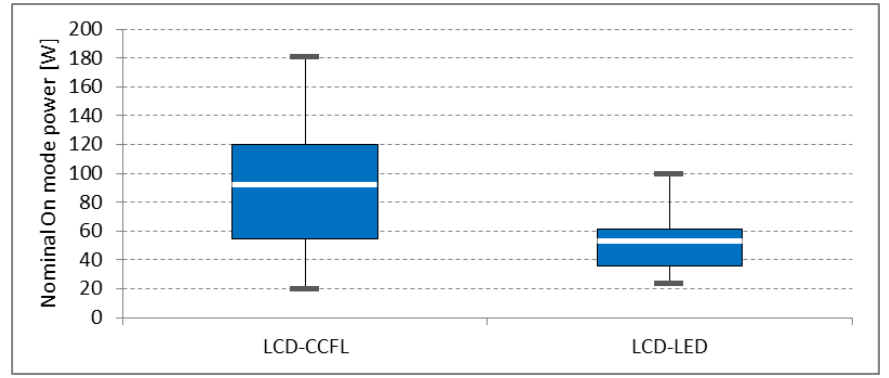
Figure 3. Statistical analysis of nominal on-mode power for different liquid crystal display (LCD) technologies: minimum, quartile Q1, quartile Q2 (median), quartile Q3, and maximum.